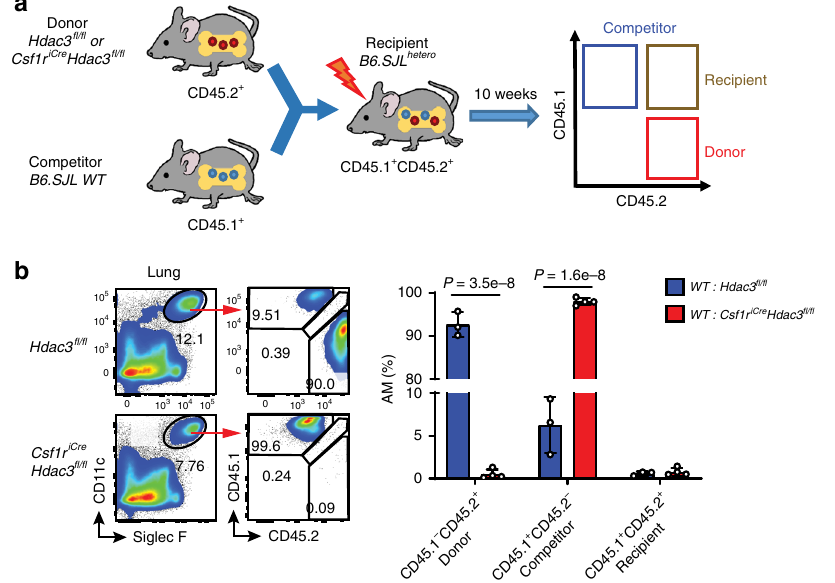
Fig. 3 Regeneration of AMs from bone marrow depends on HDAC3. The bone marrow (BM) cells from Hdac3 fl / fl and Csf1r icre Hdac3 fl / fl mice (CD45.2 + ) were co-transferred with competitor BM cells from B6.SJL mice (CD45.1 + ) into lethally-irradiated B6.SJL hetero mice (CD45.1 + CD45.2 + ). The lungs were harvested from the recipient mice 10 wks after reconstitution. a Schematic representation of the BM chimeric mouse working models. b Flow cytometry of CD45.1 and CD45.2 expression on CD11c hi Siglec-F hi lung AMs from n = 3 WT: Hdac3 fl / fl , n = 4 WT: Csf1r icre Hdac3 fl / fl mice. Bars represent mean ± SD of biologically-independent samples. All P values were obtained using the Student ’ s two-tailed unpaired t test. Source data are provided as a Source Data fi